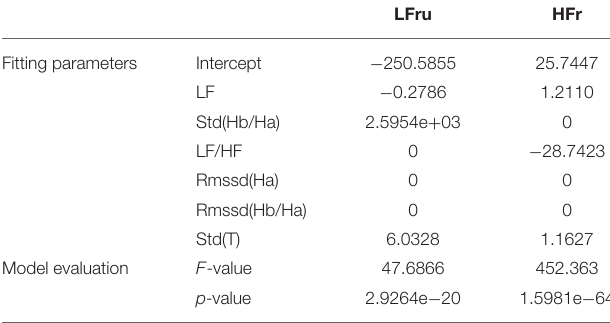
TABLE 3 | Using sensitive PPG features to fit the improved HRV parameters.